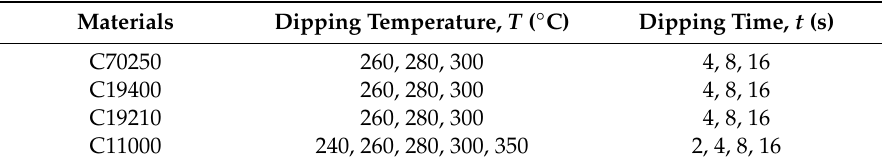
Table 5. Experimental parameters for hot-dipped